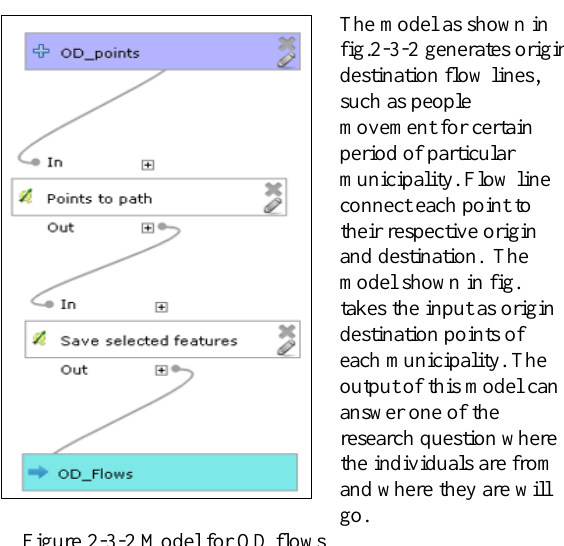
Figure 2-3-2 Model for OD